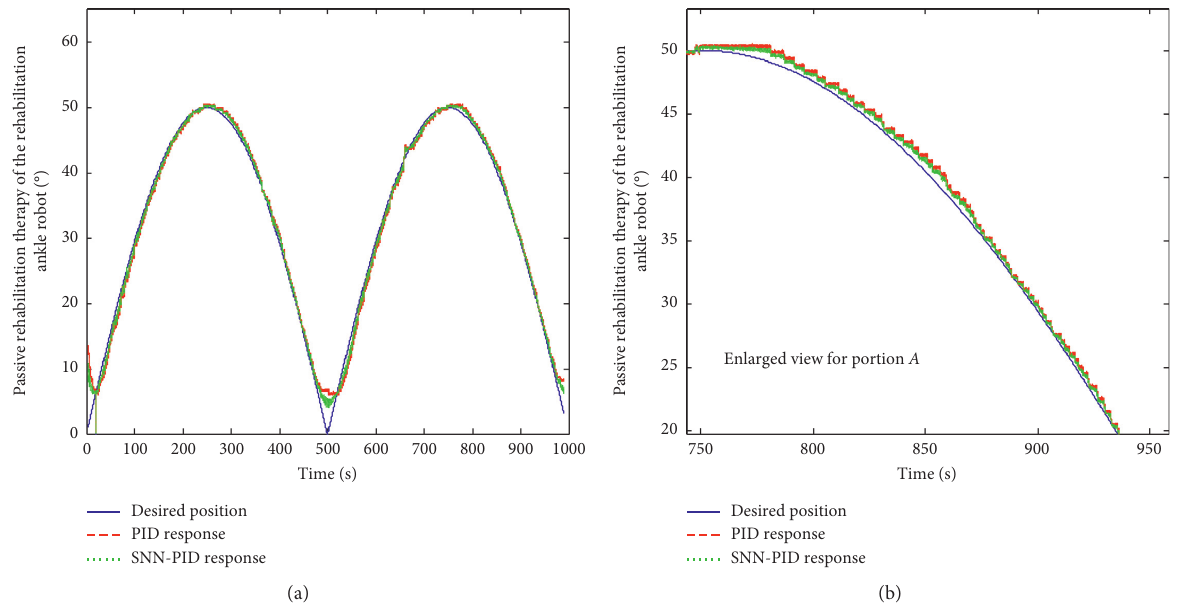
Figure 13: Passive rehabilitation therapy experiment under a half sinusoidal wave excitation of 0.002Hz with amplitude 50 ° : (a) tracking performance; (b) enlarged view for portion A in